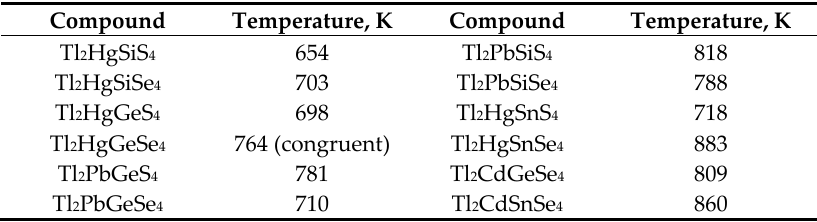
Figure 2. DTA curve of the Tl 2 CdGe 3 Se 8 compound and photo of this compound. Table 1. Peritectic formation temperatures of the 2-1-1-4 compounds.